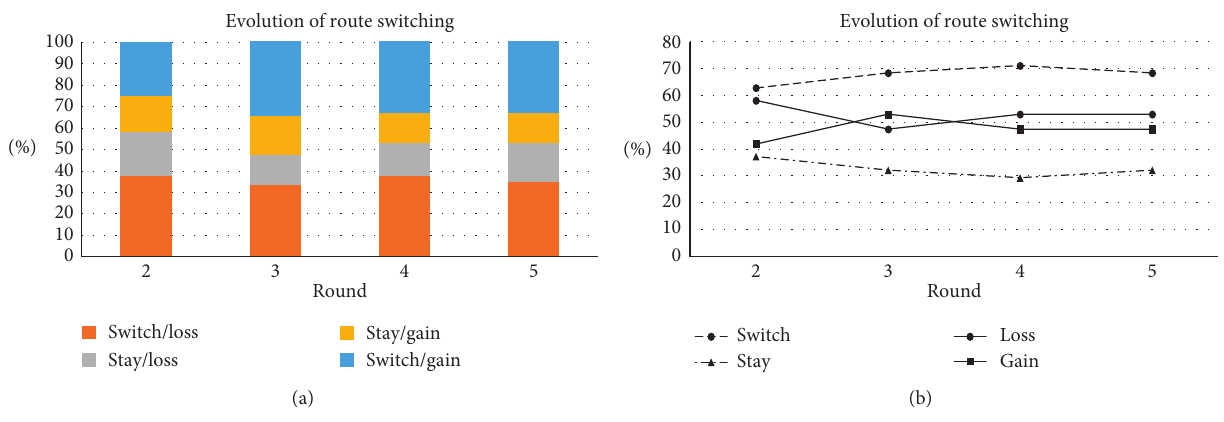
Figure 5: Evolution of route choice behavior under scenario 4. (a) Probability of each state. (b) Propensity of each state.